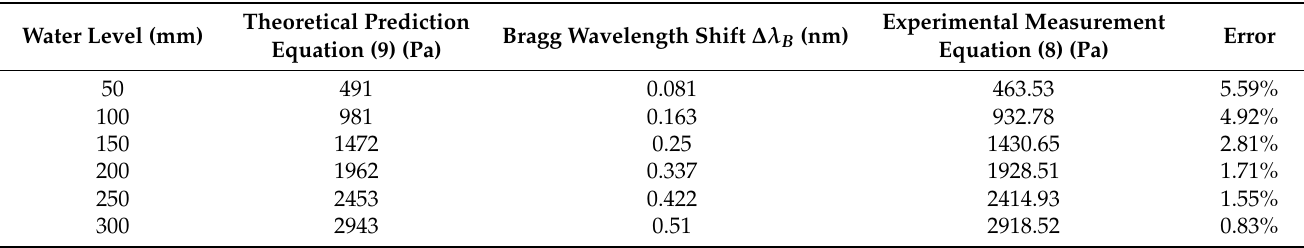
Table 1. Experimental measurement and theoretical prediction of hydrostatic pressure under various water levels with diaphragm thickness of 0.5 mm.